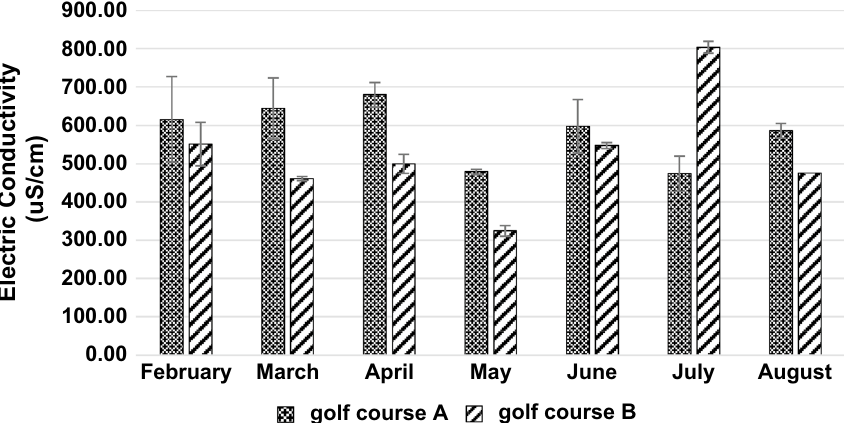
Table 3 Descriptive statistics of physicochemical parameters in the soil samples according to the UV-TW and FW irrigation